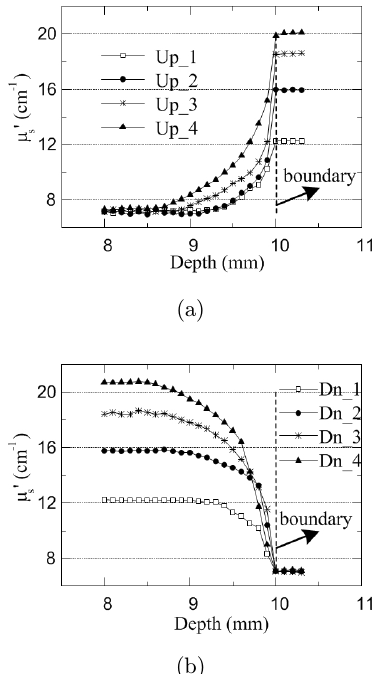
Fig. 6. Artifacts in phantom models (a) base-up modes (b) base-down